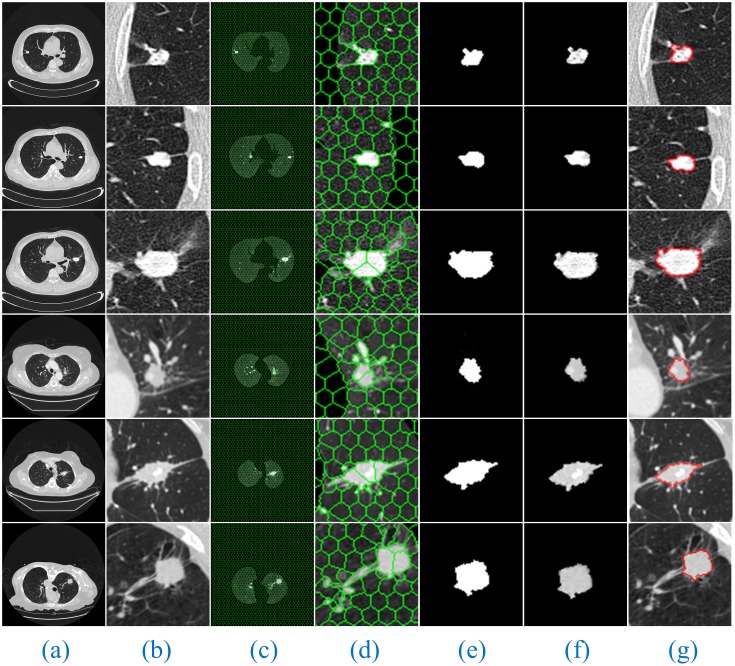
The segmentation results of our method for juxta-vascular nodules.The detailed descriptions are the same as shown in Fig 8.